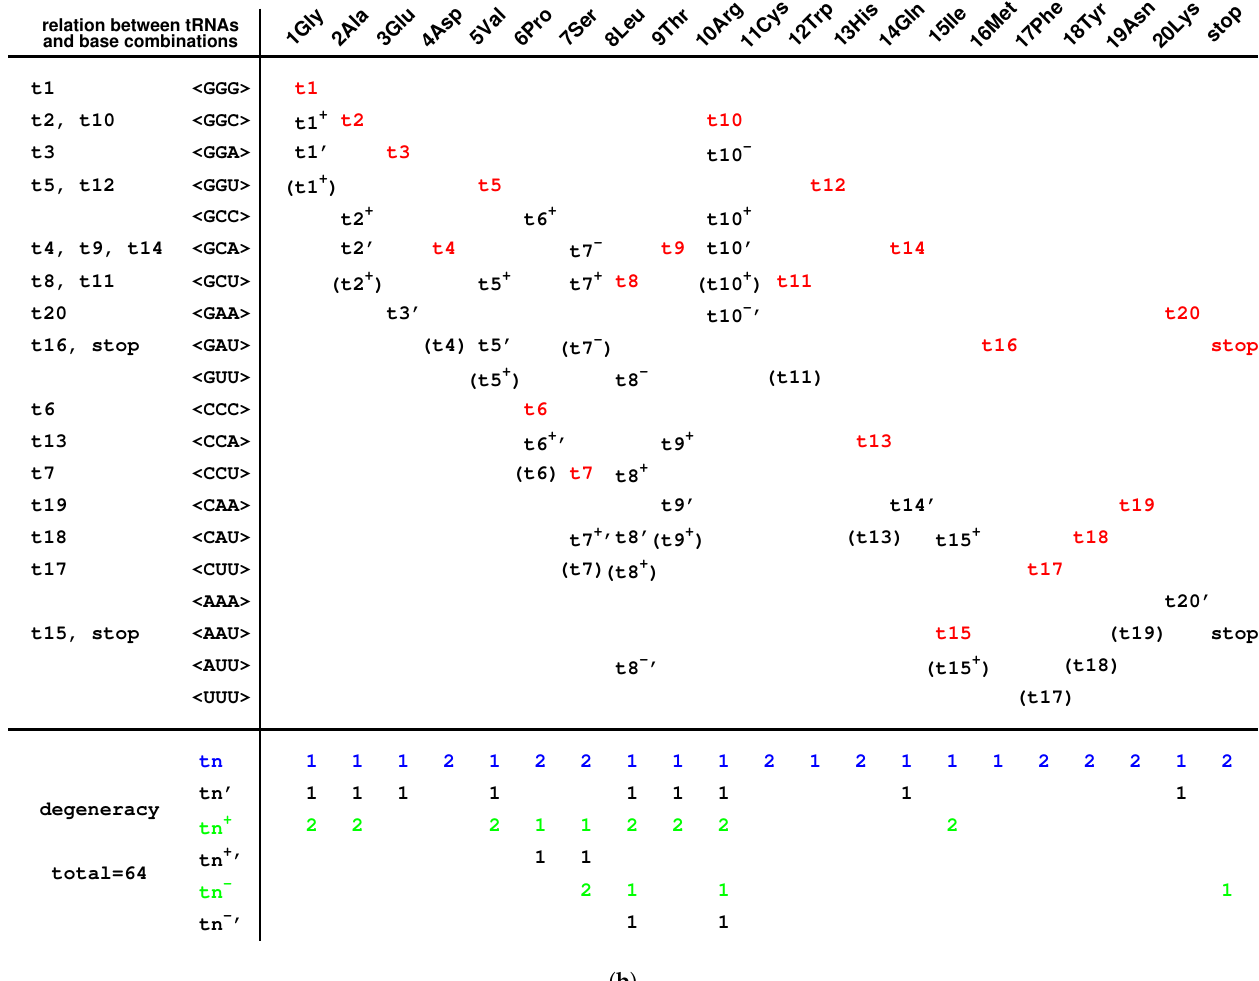
Figure 6. ( a ) The assembly of tRNAs. The tRNAs t 1- t 20 with anti-codons (Figure 5c) are listed here to carry the amino acids from No .1 to No .20, respectively. The two complimentary single-stranded RNAs for each tRNA join together and fold into a cloverleaf shape by taking advantage of the complementarity between the two strands. The joining position of the two strands is near to the 3 (cid:48) side of the anti-codon loop, which agrees with the position of introns in tRNA genes in observations. The anti-codons situate in the 3 (cid:48) -ends of the y t strand or R t strand. The palindromic sequences tend to form loops of the tRNAs. The para-codon of tRNA are non-palindromic or palindromic which adapt to the aaRSs (Figures 7 and 8). ( b ) The cognate tRNAs. Explanation of the number of canonical amino acids as 20 based on the relationship between the types of cognate tRNAs and the 20 types of base combinations. The primer tRNAs generally appeared earlier than the derivative tRNAs. The primer tRNAs generally distribute along the diagonal line due to the chronological arrangements for both the 20 amino acids and the 20 base combinations, considering the substitution order G , C , A , U along the roadmap. The codon degeneracies 6, 4, 3, 2, and 1 are due to the tRNA evolution from tn to tn + and tn − , as well as from tn to tn (cid:48) , etc., all of which can be recognised by the corresponding aaRSn